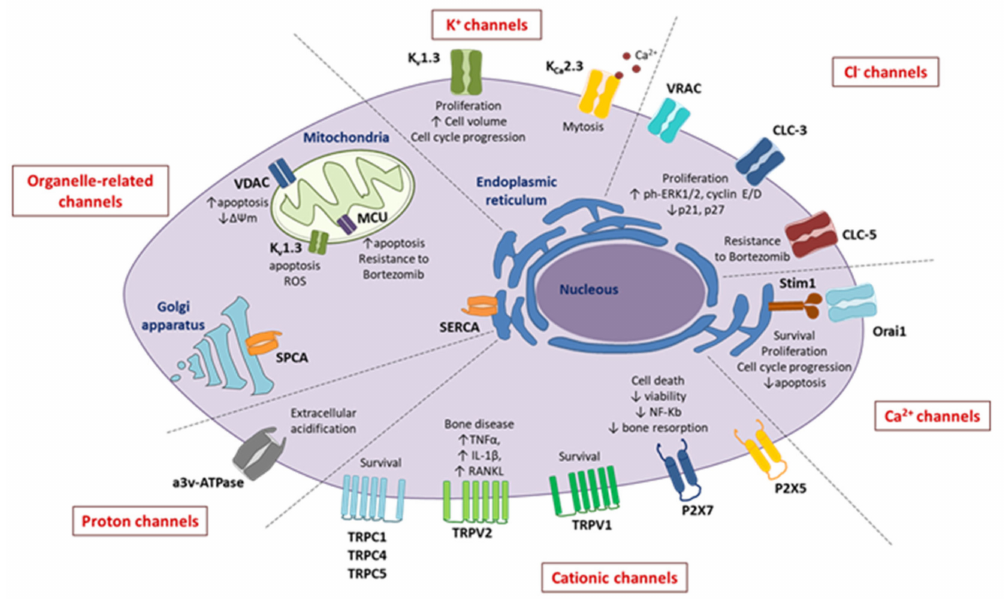
Figure 1. Schematic representation of ion channels/exchangers expressed in MM cells, which may be involved in MM pathogenesis and drug